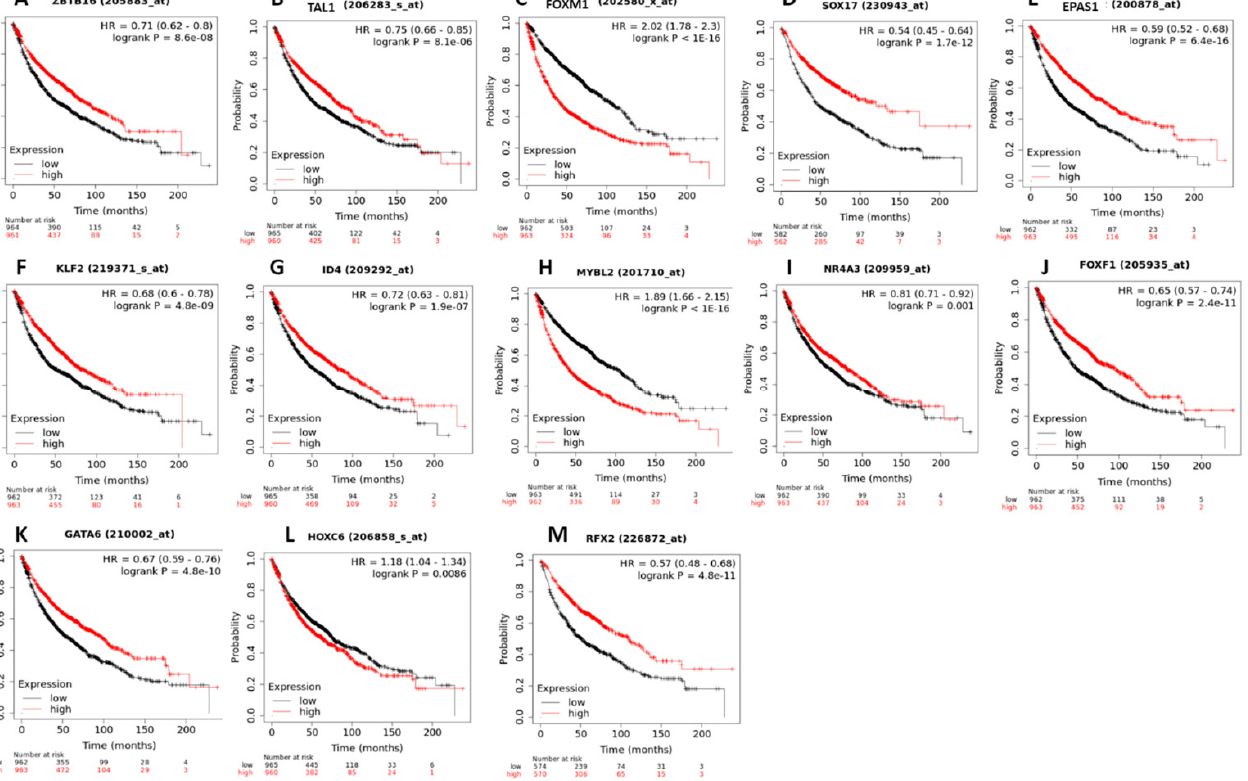
Figure 11. KM plots of the top winning transcription factors associated with lung cancer patients' survival, and with a significant logrank p -value . ( A ) ZBTB16, ( B ) TAL1, ( C ) FOXM1, ( D ) SOX17, ( E ) EPAS1, ( F ) KLF2, ( G ) ID4, ( H ) MYBL2, ( I ) NR4A3, ( J ) FOXF1, ( K ) GATA6, ( L ) HOXC6, ( M )